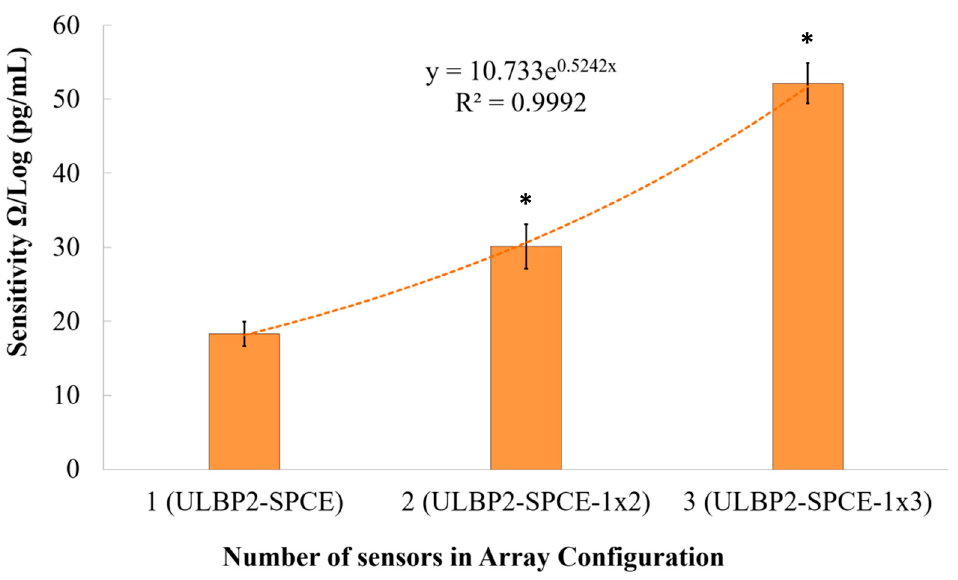
Figure 11. The effect of an array configuration on the immunosensor’s sensitivity. Here, * represents a statistically significant (p value < 0.05) difference between ULBP2-SPCE (i.e., 1 × 1 array) and other array configurations, such as ULBP2-SPCE-1 × 2 (i.e., 1 × 2 array) and ULBP2-SPCE-1 × 3 (i.e., 1 × 3 array).